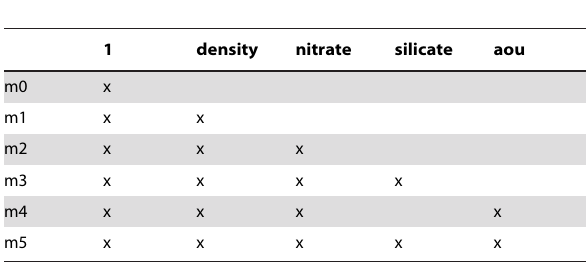
Table 2. Regressors for the models used to account for environmental variability are indicated by